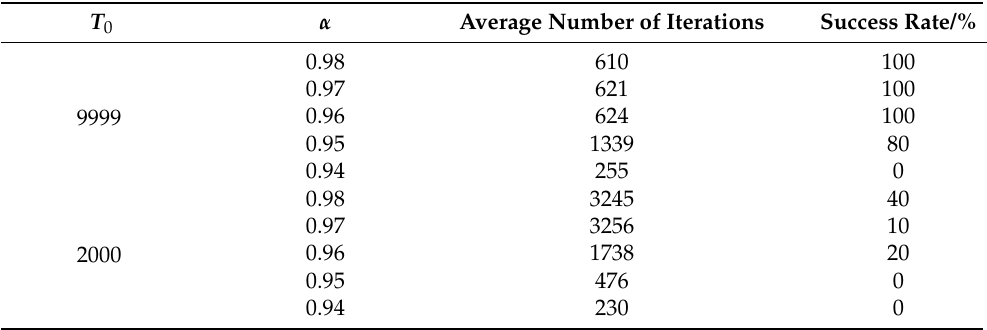
Table 5. Performance results for DA-APF (mean values from 10